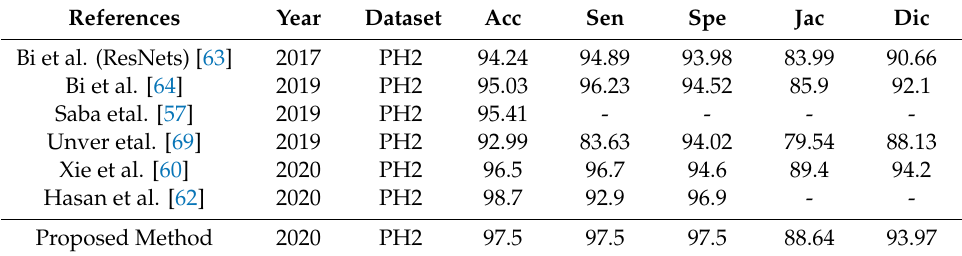
Table 9. The comparative study of the proposed segmentation performance (%) on PH2 dataset.